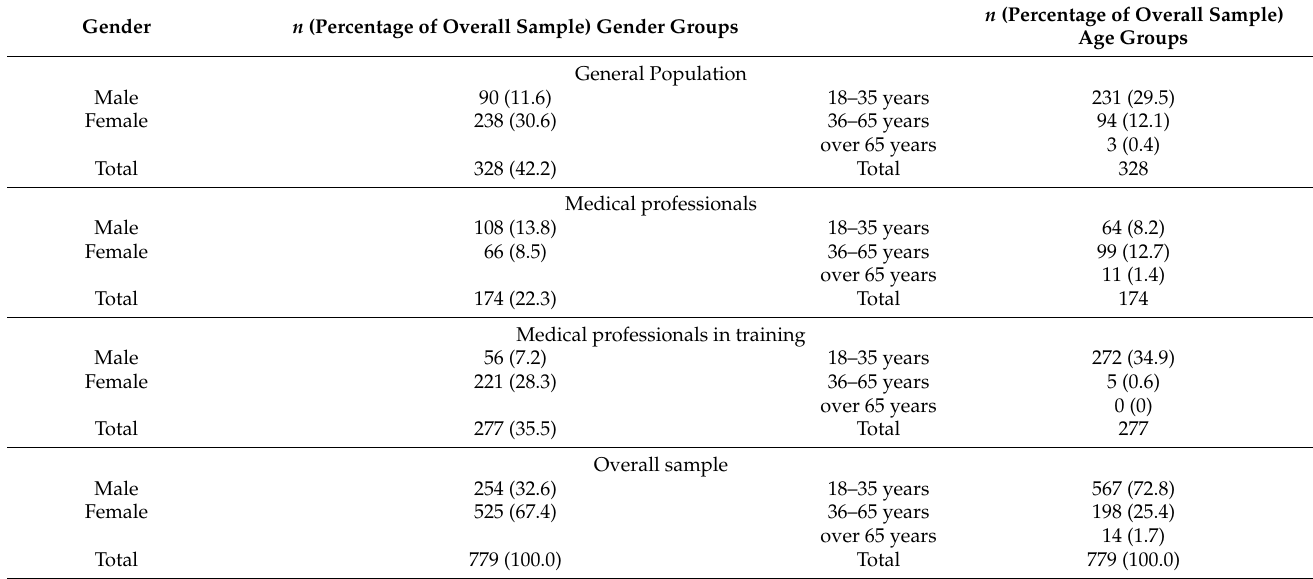
Table 1. Sample sizes of the three age groups within the study groups, sample sizes of the two gender groups for the respective study